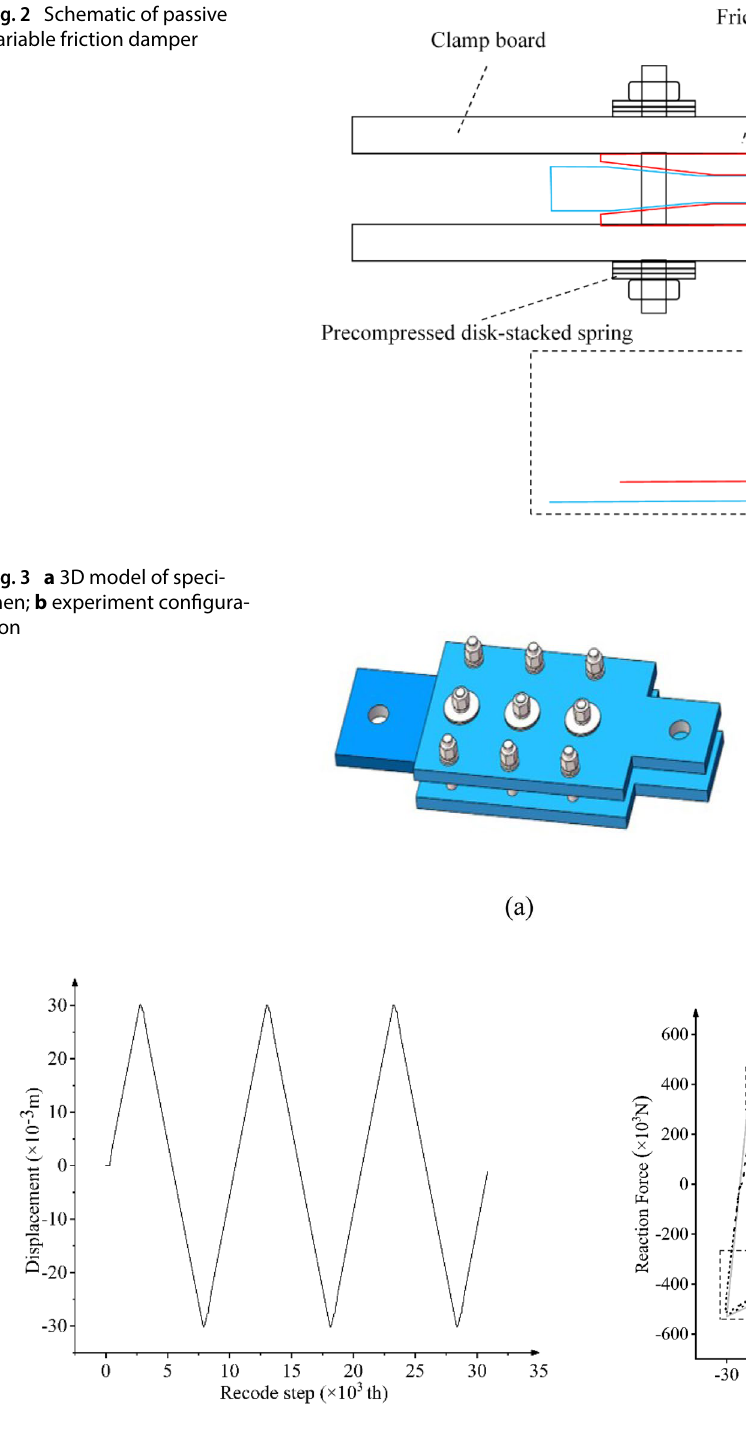
Fig. 2 Schematic of passive variable friction damper